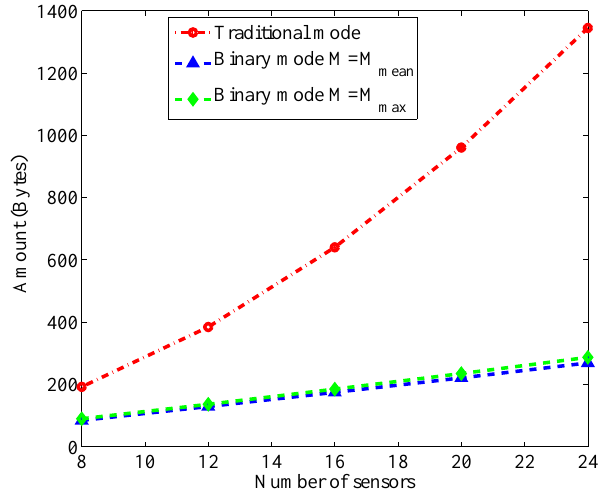
Figure 5. Tha amount of transmitted data for the two modes versus number of